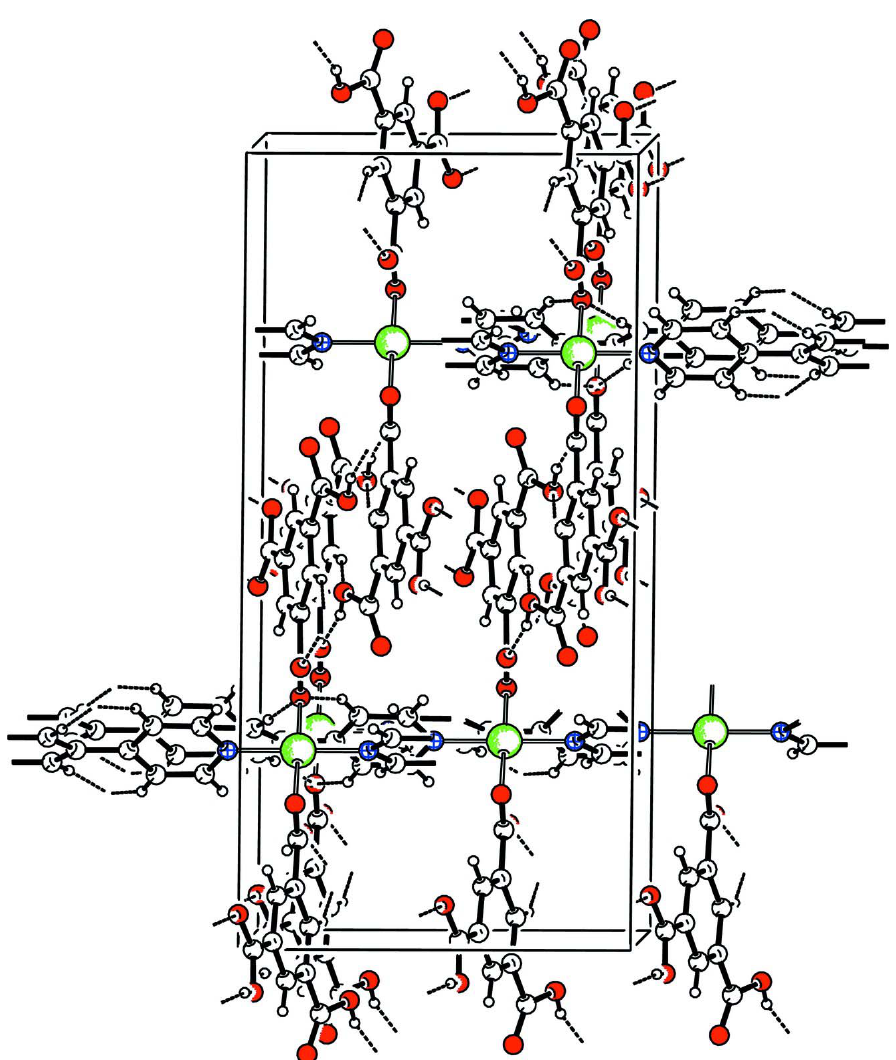
Three-dimensional structure of (I) arising by means of hydrogen bonds. Displacement ellipsoids are drawn at the 50% probability